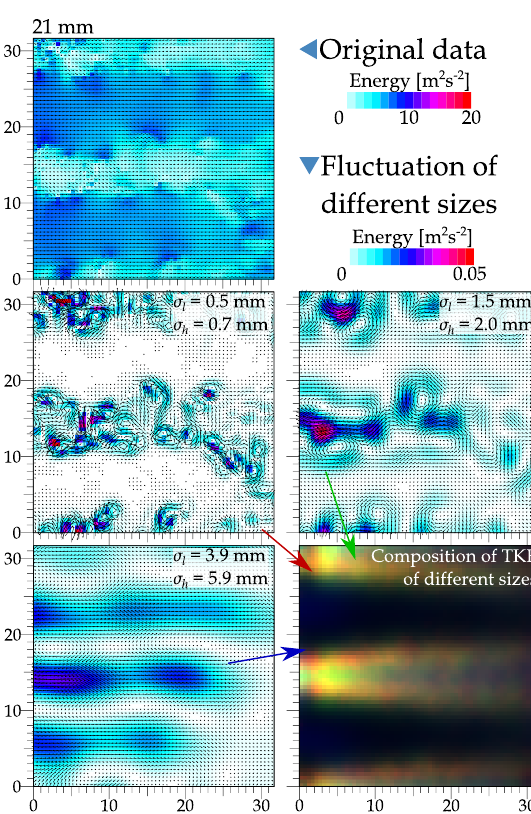
Fig. 8. Top : The power spectral density as a function of the dis- tance from the grid (the x 0 means the leading side of the probed areas) at constant Reynolds number Re = 3 . 1 · 10 3 . Bottom : the power spectral density divided by square of velocity as a function of Reynolds number at constant distance from the gird x 0 = 250mm = 16 M . For comparison there is plotted the fa- mous Kolmogorov − 5 / 3